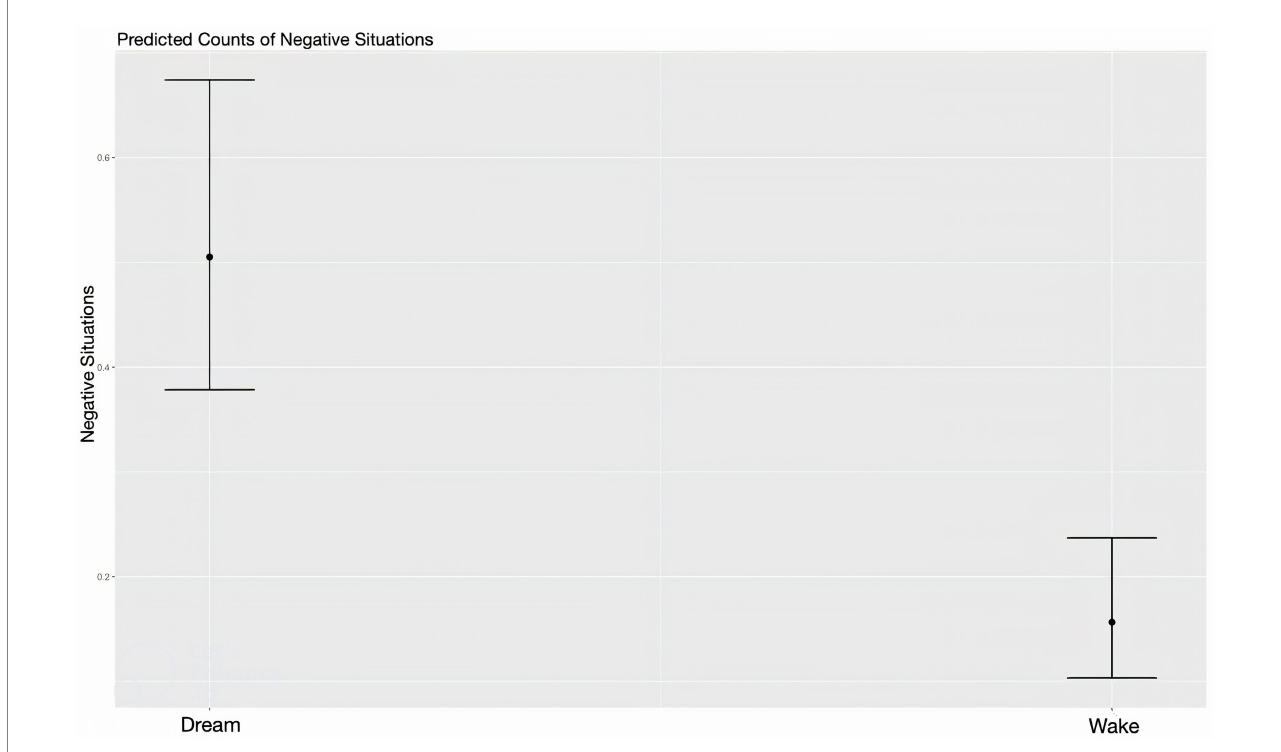
FIGURE 2 Predicted values (marginal effects) for report state and negative social